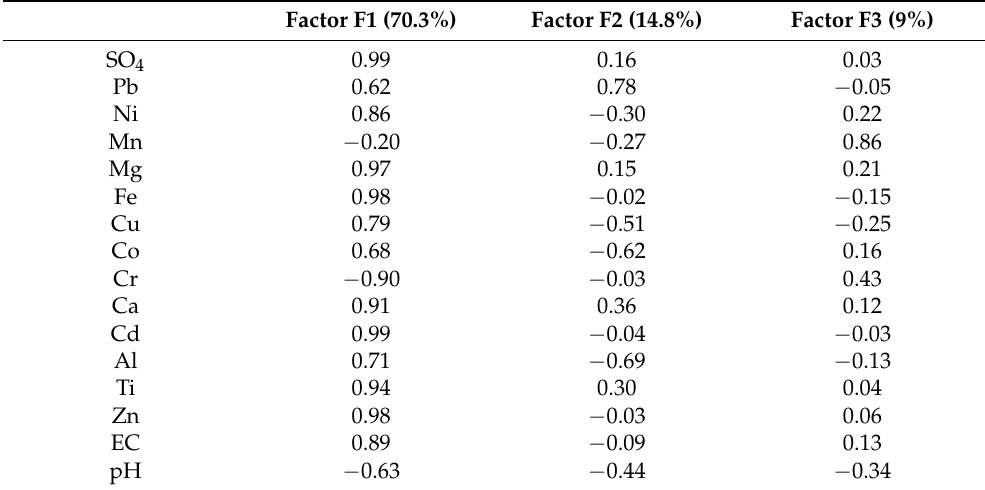
Table 5. Correlation between variables and factors (F1 and F2) from observation wells installed on the abandoned Aldermac mine site, in 2014 (tenth